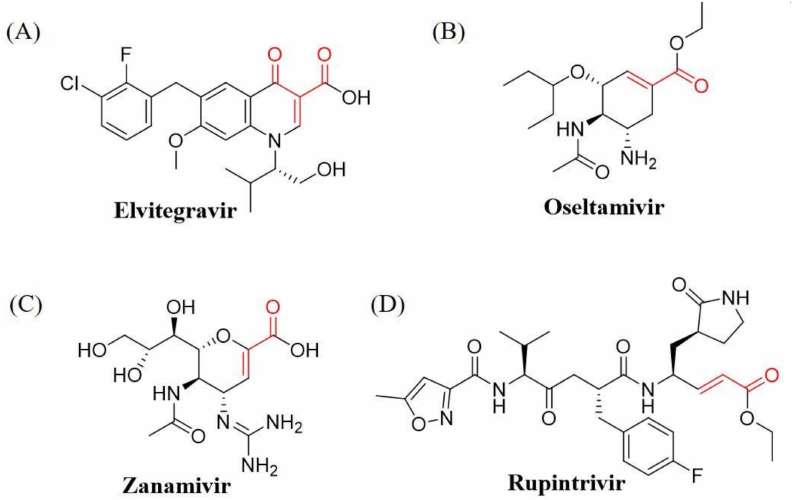
Figure 3. Antiviral drugs have a high potential to participate in a Michael addition reaction. The drug compounds ( A ) elvitegravir, ( B ) oseltamivir, ( C ) zanamivir, and ( D ) rupintrivir, which have a favorable Michael acceptor moiety (red bonds and atoms), have high potential to partake in a Michael addition